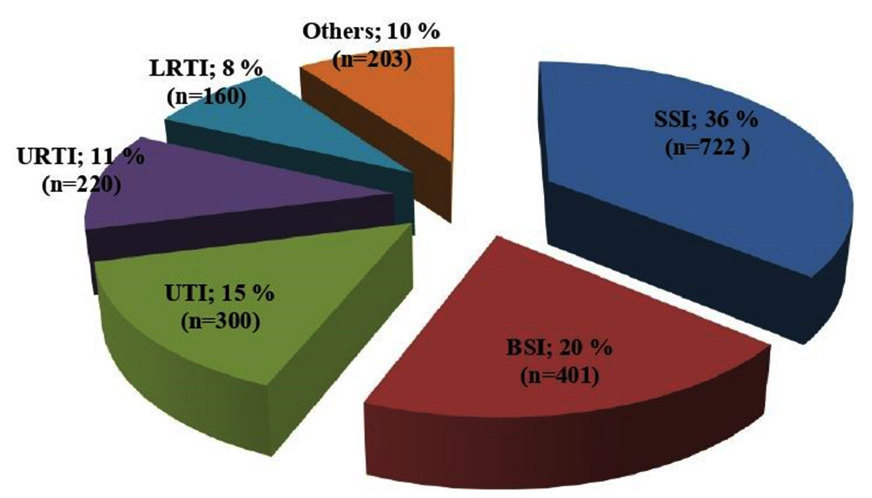
Fig. 1. Different types of nosocomial infections in MUHs: A total of 2006 nosocomial isolates was obtained. Surgical site infection (SSI) represented the commonest nosocomial infection (36%) followed by blood stream infection (BSI), urinary tract infection (UTI), upper respiratory tract infection (URTI) then lower respiratory tract infection